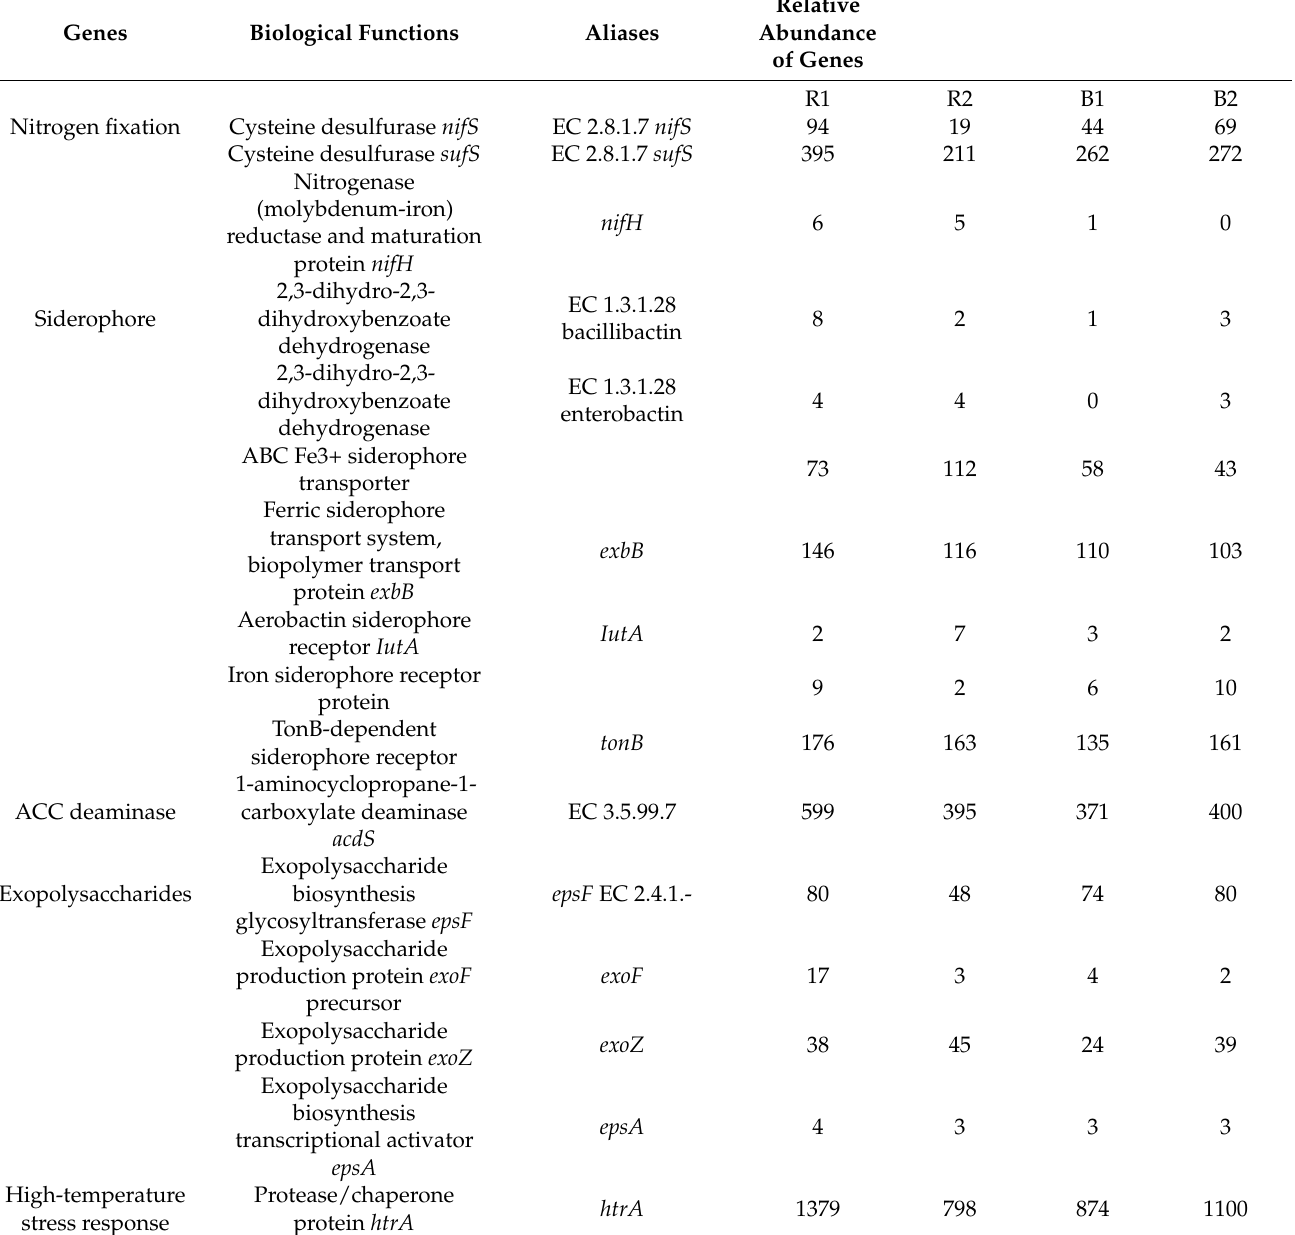
166 and 63 for both R1 and R2, while B1 and B2 had a relative abundance of 93 and 128, respectively. cspC had 456 for R1, 319 for R2, 312 for B1, and 341 for B2. The heat shock protein chaperone with aliases groEL had a relative abundance of 7318 in R1, 4453 in R2 metagenome, 4977 in B1 and 5603 in B2, while co-chaperone groES gene had 1409 for R1, 814 for R2, 1016 for B1 and 1134 for B2. CspABCEG was more abundant in the rhizosphere than the bulk soils, although rhizosphere location R1 was more enriched than R2. Table 4. Relative abundance of plant growth functional genes as observed in sunflower rhizosphere (R1, R2) and bulk (B1, B2) soil